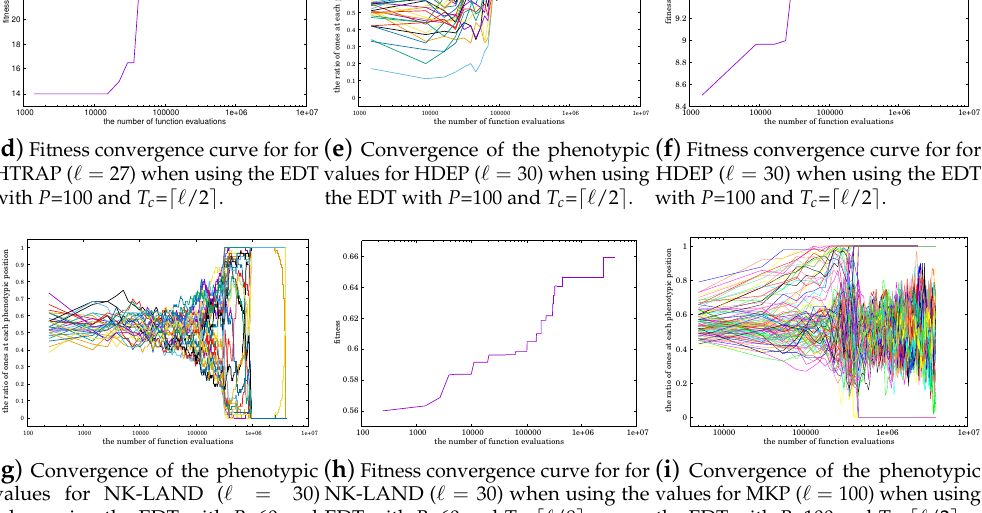
( i ) Convergence of the phenotypic values for MKP ( (cid:96) = 100) when using the EDT with P =100 and T c = (cid:100) (cid:96) /2 (cid:101) .